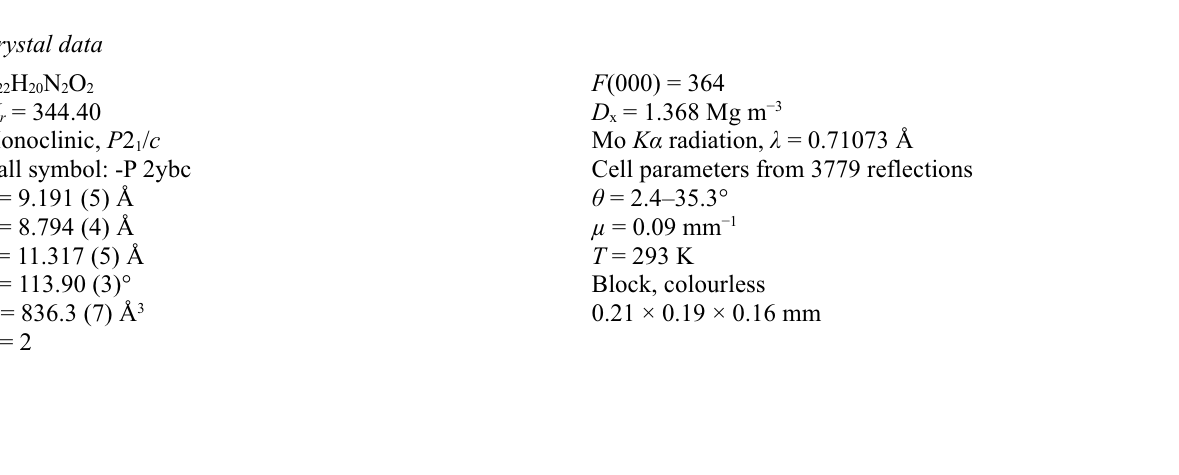
sup-3 Acta Cryst. (2009). E 65 , o581